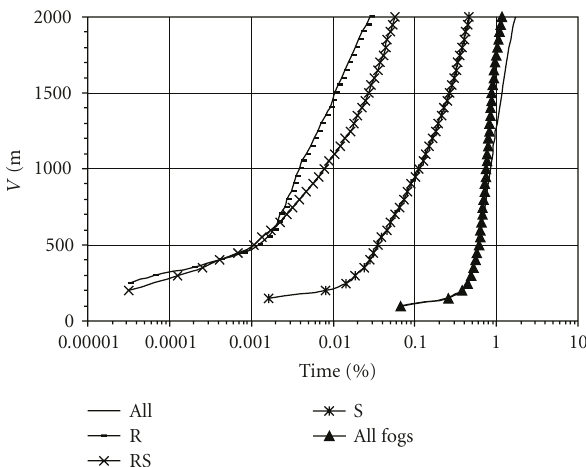
Figure 10: Obtained CDs of visibility due to all the hydrometeors combined and to the individual hydrometeors separately on the FSO path over the 6-year period of observation.